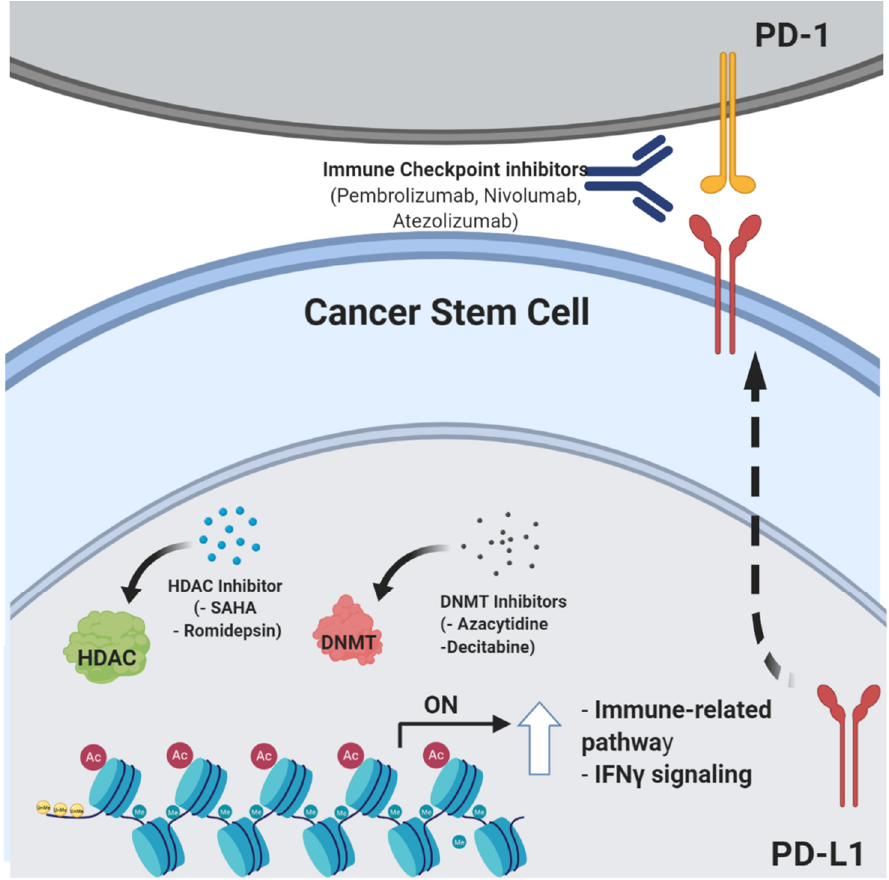
Figure 3. Schematic representing several epigenetic modulators (histone deacetylases (HDAC) and DNA methyltransferase (DNMT) inhibitors) that may act by sensitizing tumor cells to immune checkpoint blockade. Created by Biorender.